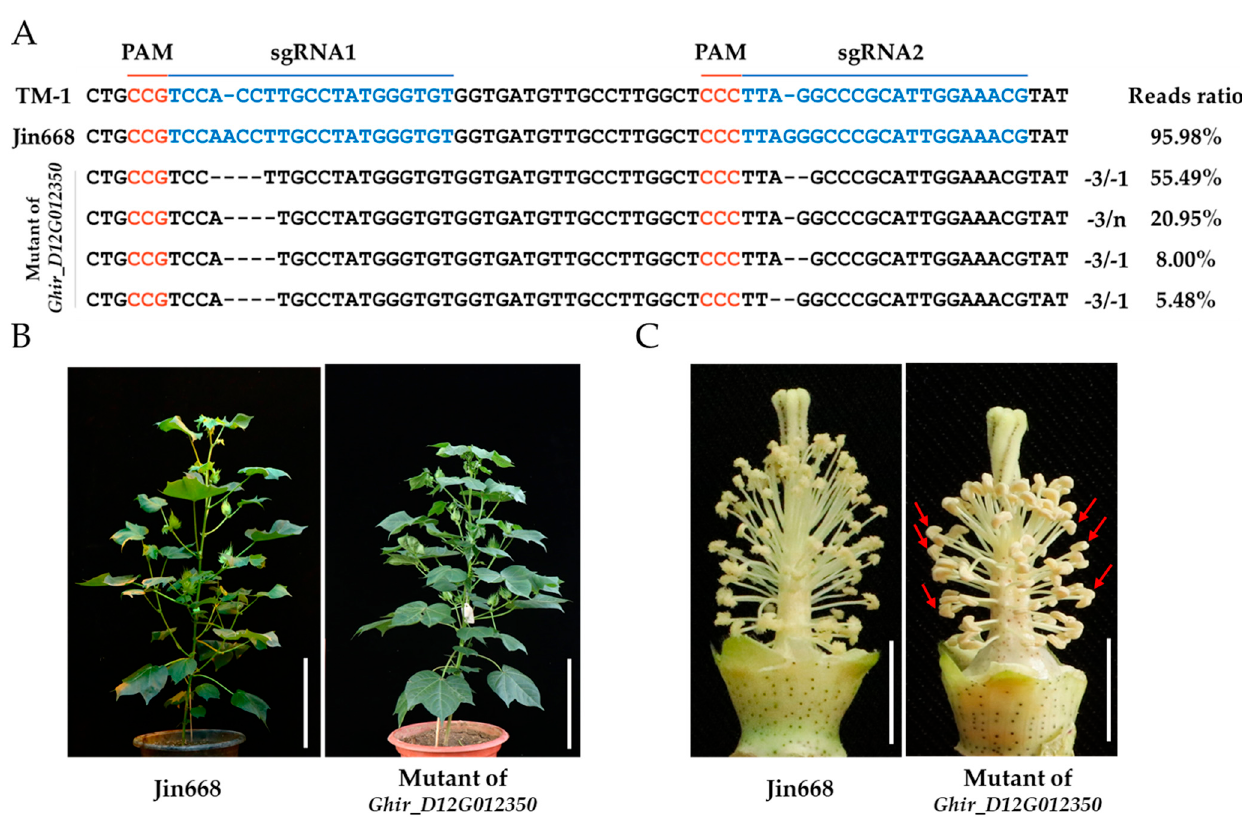
Figure 4. Genome editing of Ghir_D12G012350 causes indehiscent anther in cotton. ( A ) Genome editing in the mutant of Ghir_D12G012350 is exhibited. The sgRNA target sites and the PAM (protospacer adjacent motif) regions are shown in blue and orange, respectively. TM-1—the reference genome. Jin668—the wild type (WT); ( B ) The WT and mutant plants are shown. Scale bars = 20 cm. ( C ) The flowers of WT and mutant plants are shown, with petals removed. The red arrows represent the indehiscent anthers. Scale bars = 1 cm.